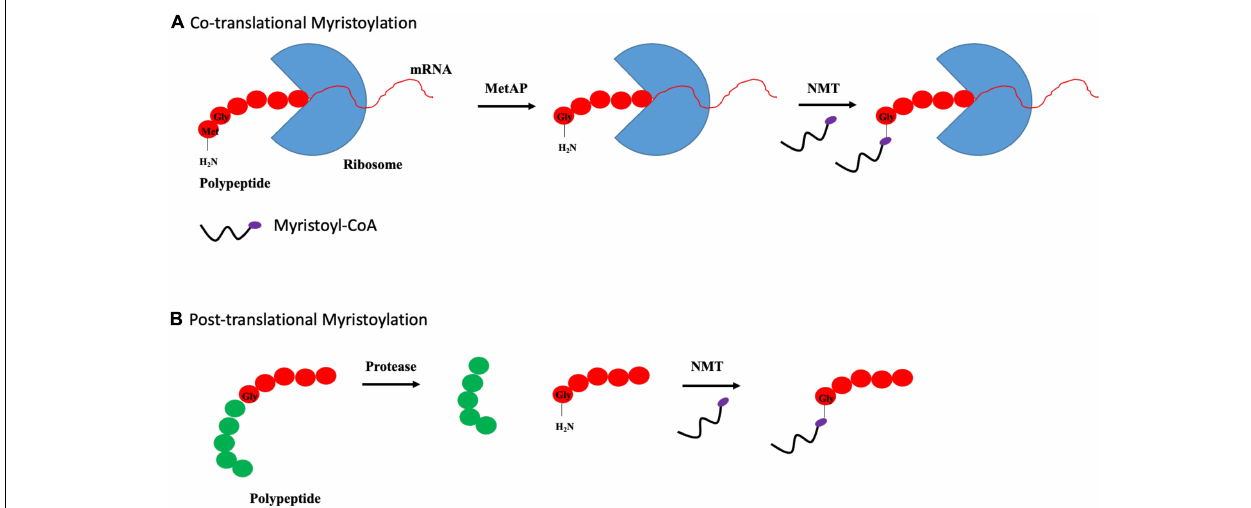
FIGURE 3 | Types of myristoylation. (A) Schematic illustration of steps involved in cotranslational myristoylation. During cotranslational myristoylation, the myristoyl group is added to the N-terminal glycine residue following cleavage of the N-terminal methionine residue on the growing polypeptide chain. (B) Posttranslational myristoylation normally occurs following caspase cleavage event, resulting in the exposure of internal glycine residue, which allows myristic acid